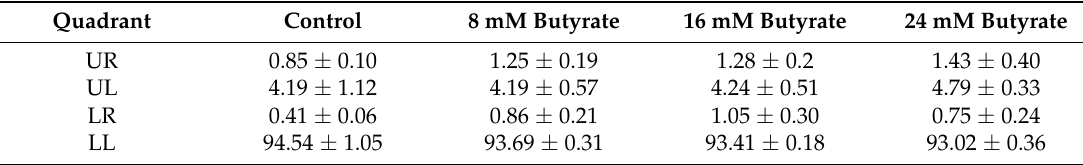
Figure 4. Effect of butyrate on the induction of the apoptosis and necrosis of MG63 cells as analyzed by propidium iodide (PI) + annexin V flow cytometry. UL (upper left): Necrosis, UR (upper right) and LR (lower right): Apoptosis. One representative PI and annexin V flow cytometry histogram was shown. ( A ) Control and ( B ) 16 mM butyrate-treated cells. Table 1. Induction of apoptosis and necrosis of MG63 cells by various concentrations of butyrate as analyzed by PI and annexin V flow cytometry ( n = 4). No statistically significant difference was noted between groups. LL (lower left).